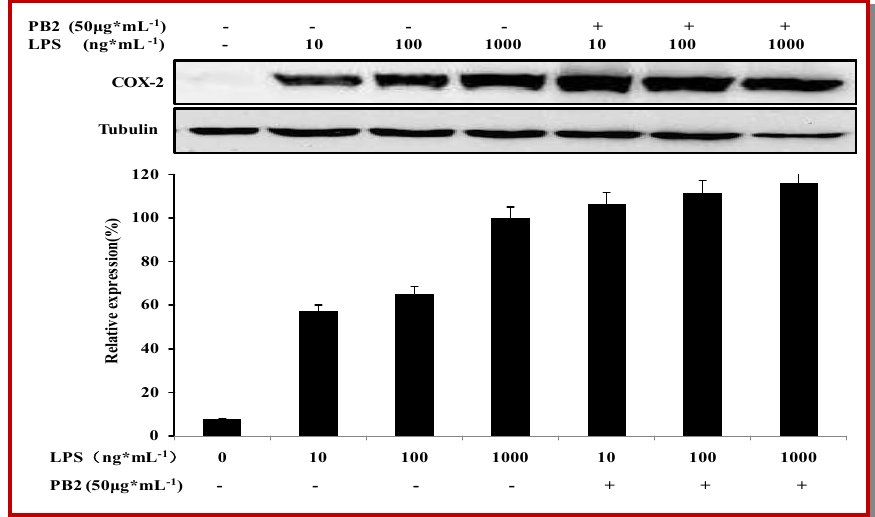
Figure 5: Effects of PB2 in reverse pre-treated way on COX-2 expression in LPS-induced RAW 264.7 macrophage